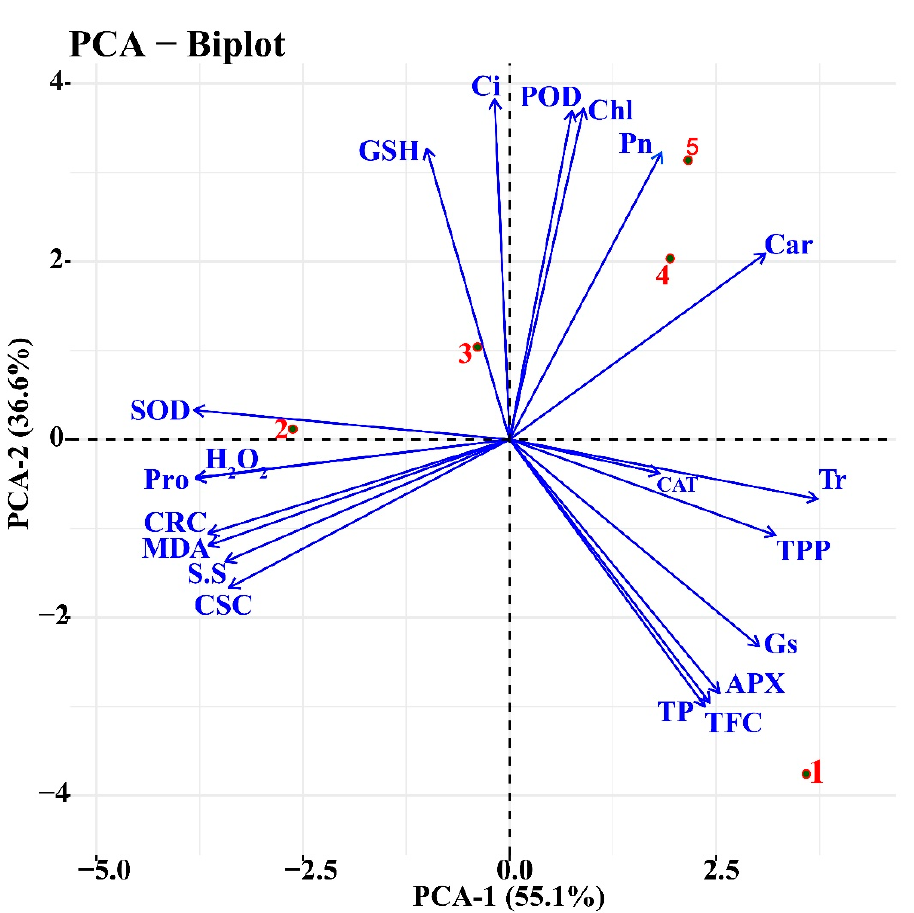
Figure 9. Principal component analysis of phenotypic, physiological, and biochemical traits under different levels of Cr treatments in sweet potato plant. Abbreviations are the same as mentioned in the legend in Figure 8. Red dots and numbers representing Cr treatments; (1) Ck, (2) 25 µM, (3) 50 µM, (4) 100 µM, and (5) 200 µM.